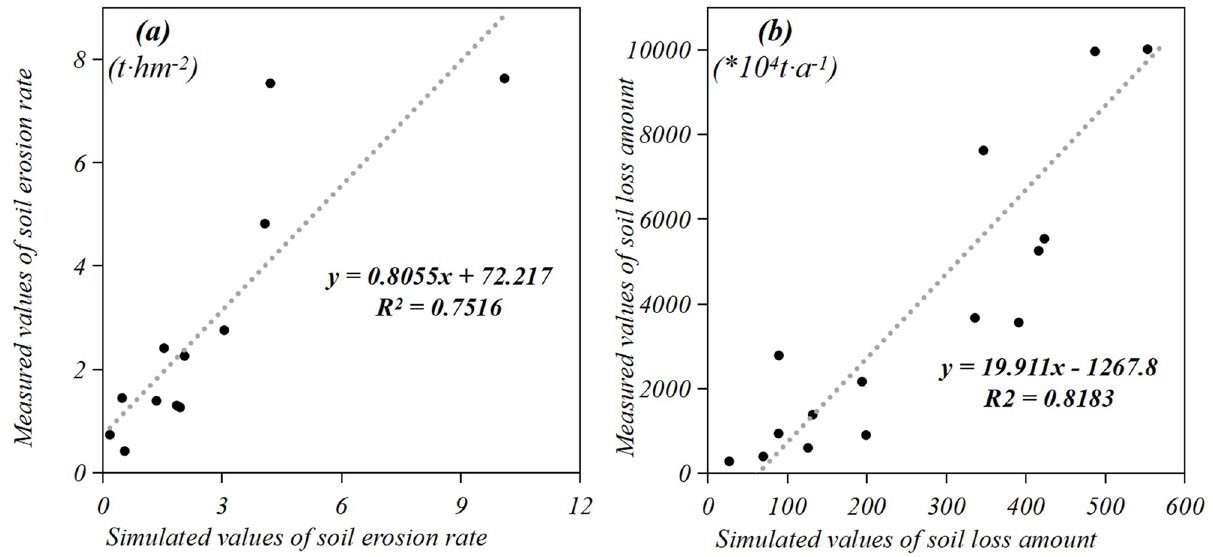
Fig 11. Verification of the soil erosion rate and soil loss